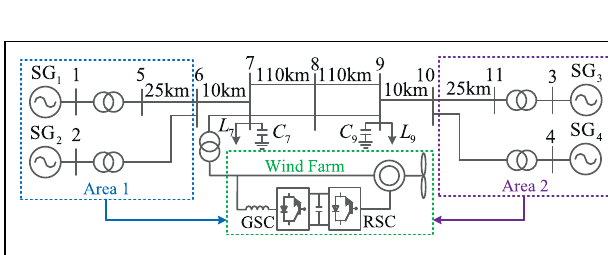
FIGURE 3 | Configuration of the simulated power